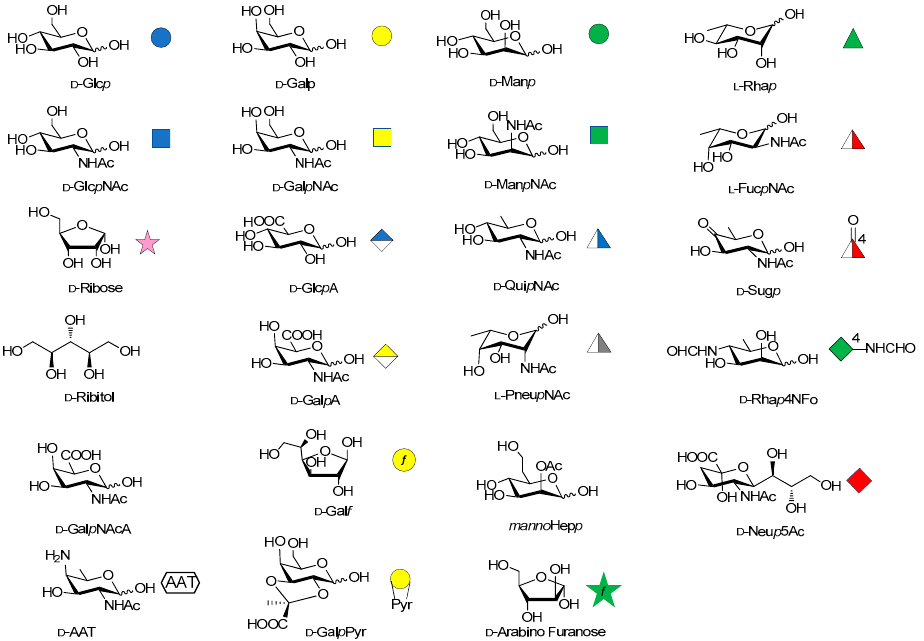
Figure 1. Representation of the monosaccharide building blocks contained in the glycans of pathogen cell wall PS accounted in this manuscript.